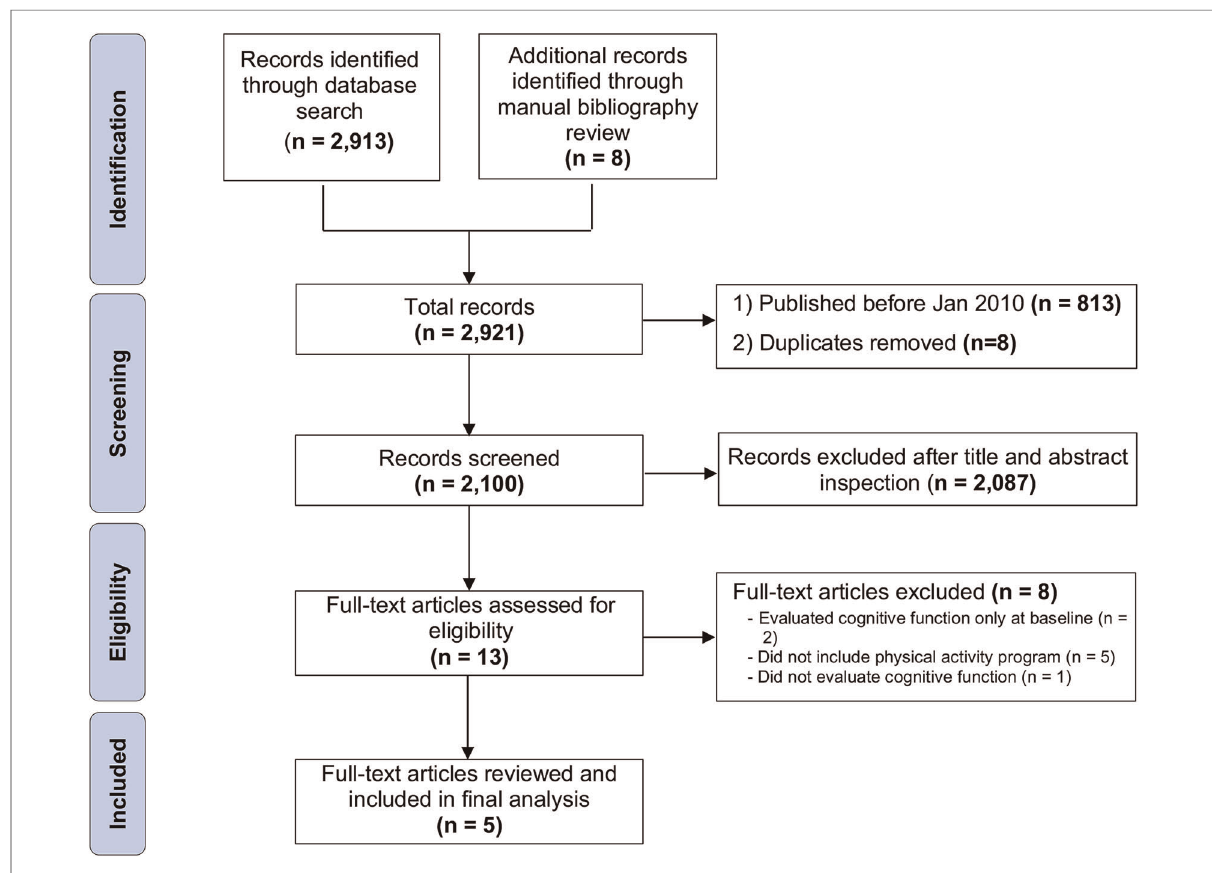
FIGURE 1 PRISMA fl ow diagram of identi fi cation, screening, and inclusion of eligible